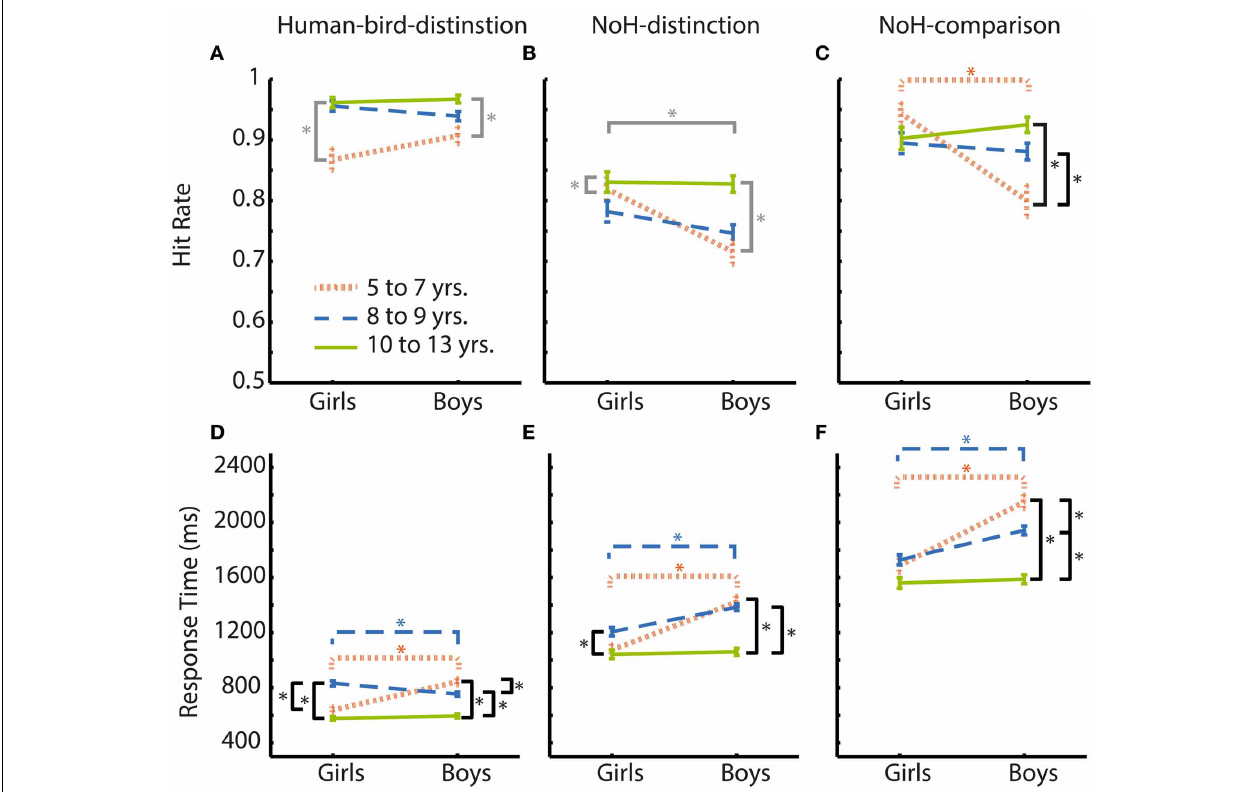
FIGURE 4 | Hit rates and RTs according to age group and gender for all paradigms. Age groups are represented by different colors: youngest = orange thinly dashed lines, middle = blue broadly dashed lines, oldest = green solid lines. Girls’ responses are shown on the left side of each graph, boys’ responses on the right. Comparisons between age groups and genders are illustrated for Human-bird-distinction (left, A,D ), NoH-distinction (middle,